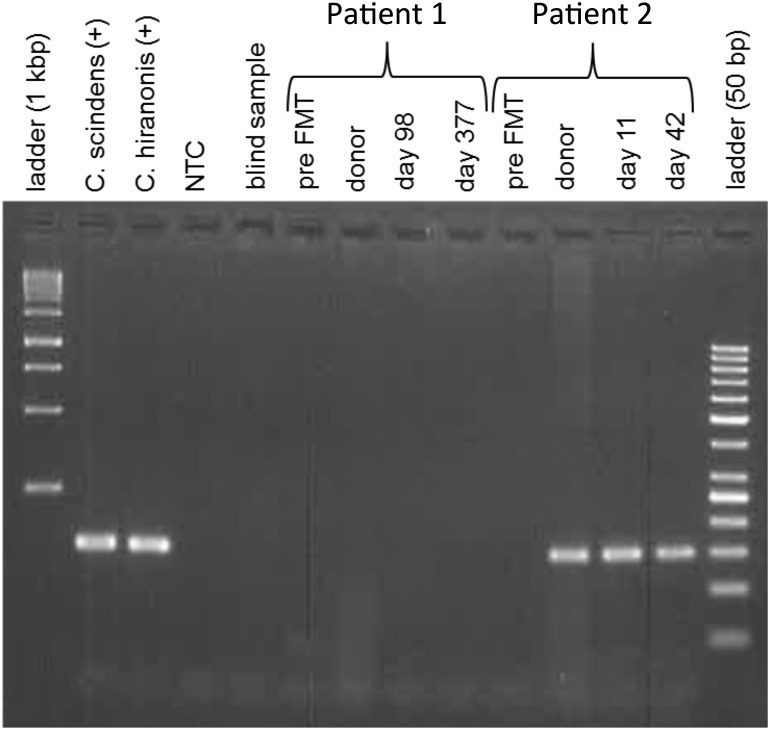
Presence of the baiCD gene cluster in 2 patients before and after fecal microbiota transplantation (FMT).Agarose gel loaded with products of an end-point PCR detecting the baiCD gene cluster (92 bp) of C. scindens and C. hiranonis (positive control, lane 2+3; negative controls: lane 4+5). In patient 1 (lanes 6–9), baiCD gene cluster was neither detected before, nor after FMT or in the donor. Patient 2 (lanes 10–13) was baiCD-negative before the procedure, but persistently positive after receiving FMT from a baiCD-positive donor. (Lane 1+14: 1 kbp and 50 bp DNA ladder; NTC = non-template control)).